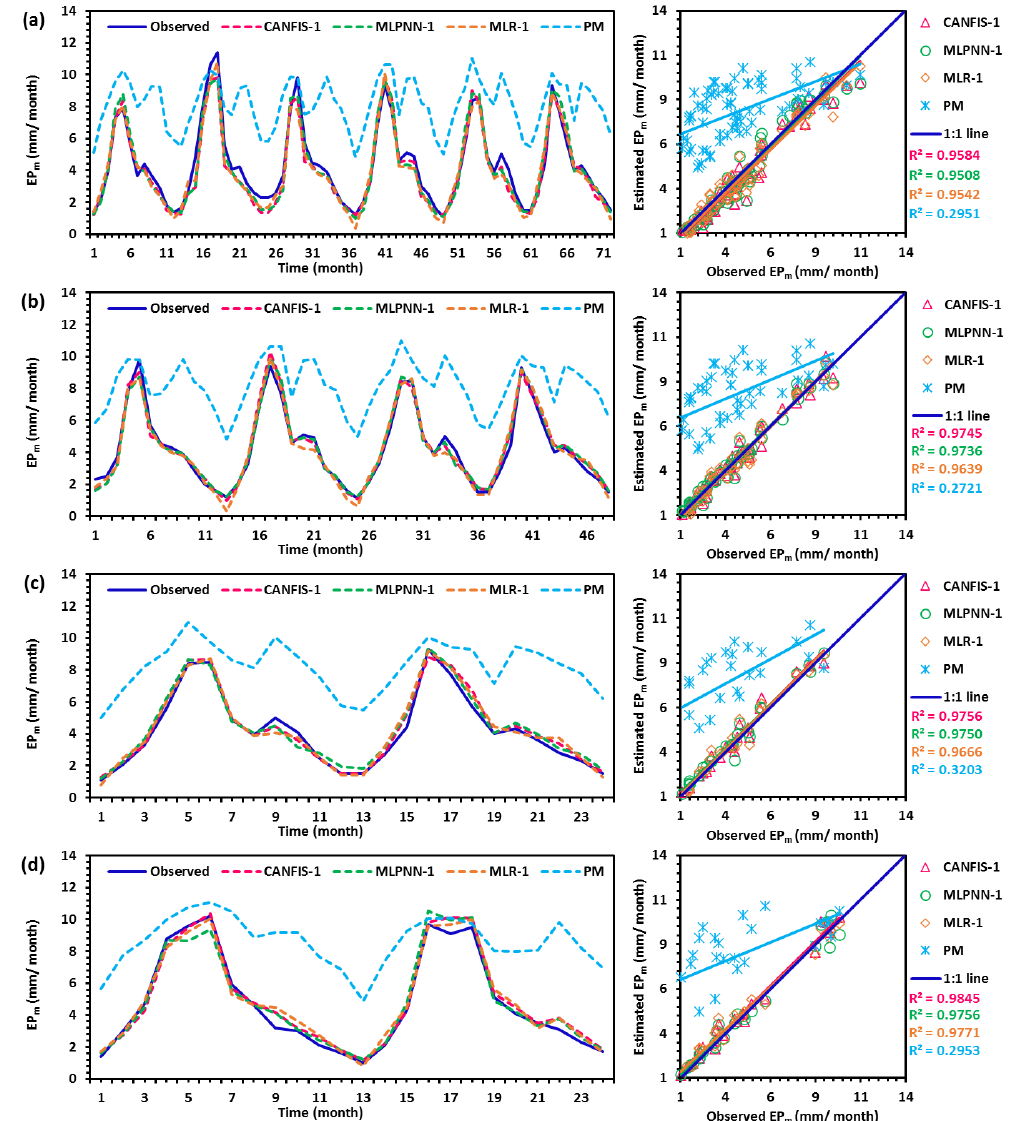
Figure 7. Comparison plots of observed and estimated monthly pan-evaporation values yielded by the CANFIS-1, MLPNN-1, MLR-1, and PM models in ( a ) scenario-1, ( b ) scenario-2, ( c ) scenario-3, and ( d ) scenario-4 during the testing period at Pantnagar station.